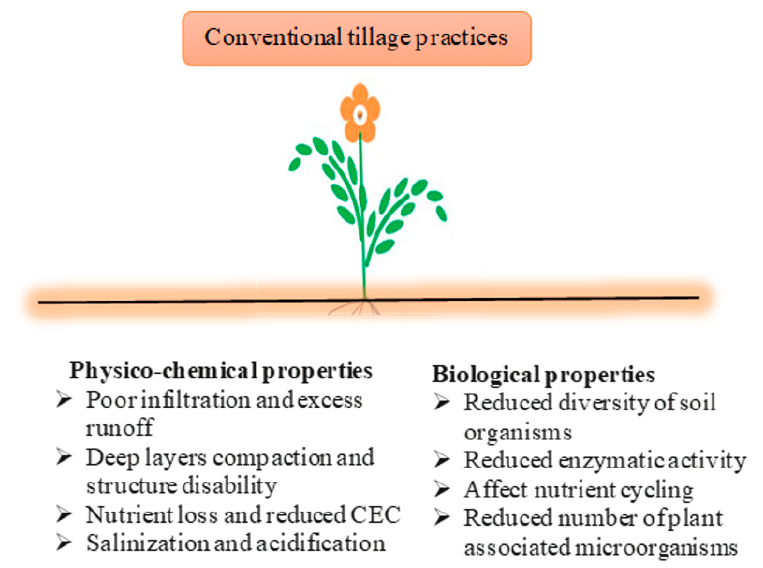
Figure 1. The impact of conventional tillage practices on the soil environment. Note: CEC denotes cation exchange capacity.